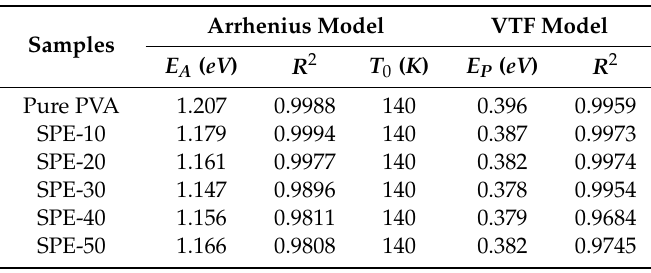
Table 2. Parameters determined through experimental data fitting using Arrhenius and Vogel– Tammann–Fulcher (VTF)